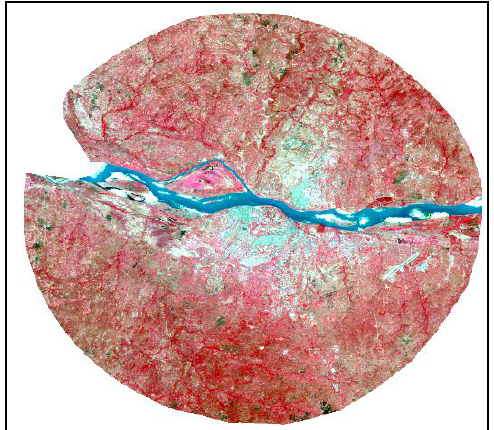
Figure 2. False Color Composition of study area.